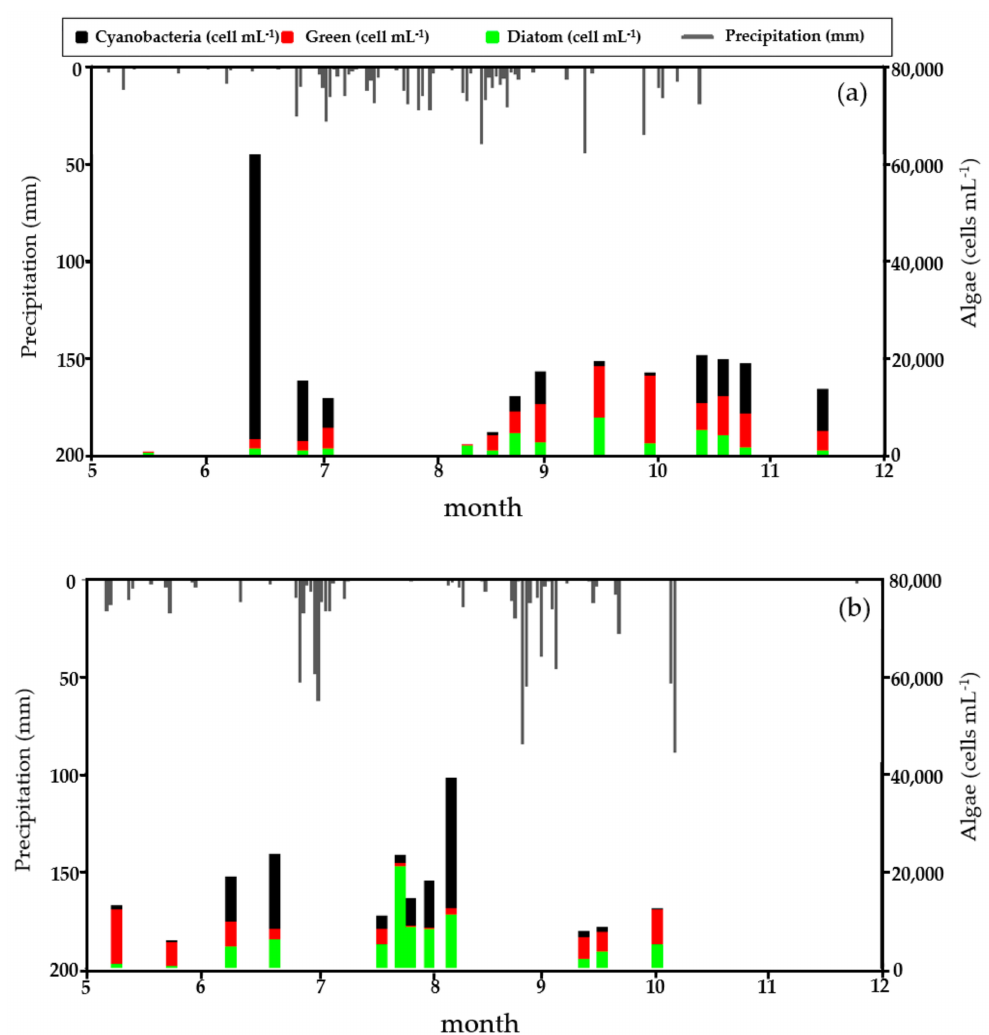
Figure 3. Temporal variations of precipitation and cell density (by phytoplankton group) at the Changnyeong Haman weir (CHW) in the Nakdong River from May (month 5) to December (month 12) in; ( a ) 2017 and ( b )